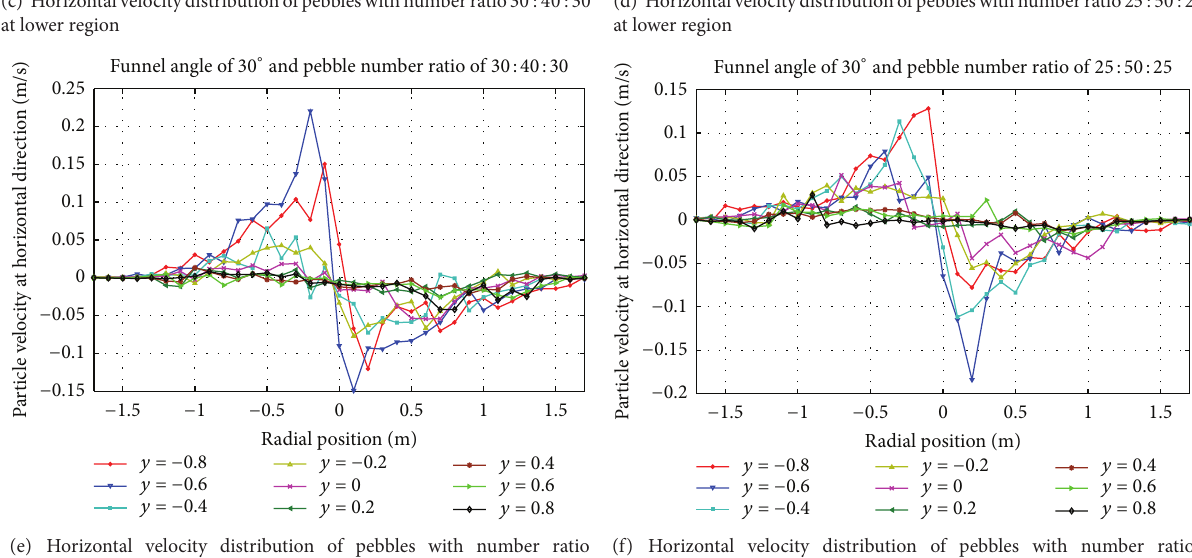
(f) Horizontal velocity distribution of pebbles with number ratio 25:50:25 at cone region Figure 7: Horizontal velocity distributions of pebbles at different number